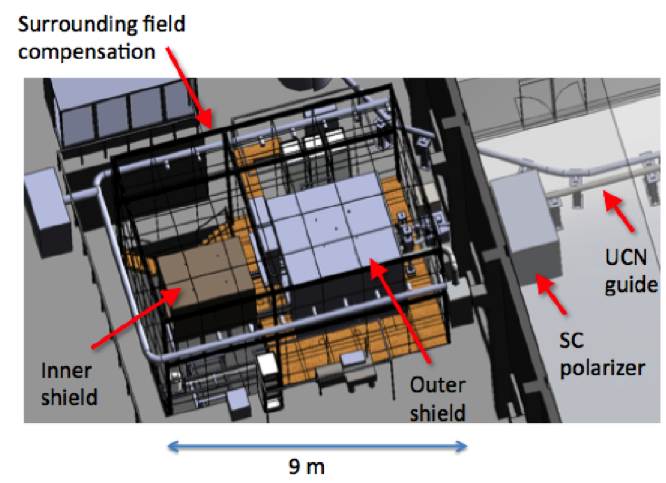
Figure 3: Schematic drawing of the installation. The UCN guide from the reactor is passing a supercon- ducting (SC) polarizer to supply perfectly polarized UCN into the EDM measurement chambers, which are placed inside the outer shield. The inner shield contians the stable field coil and can be guided into the outer shield on rails, to provide the stable magnetic field and the pulses for the Ramsey